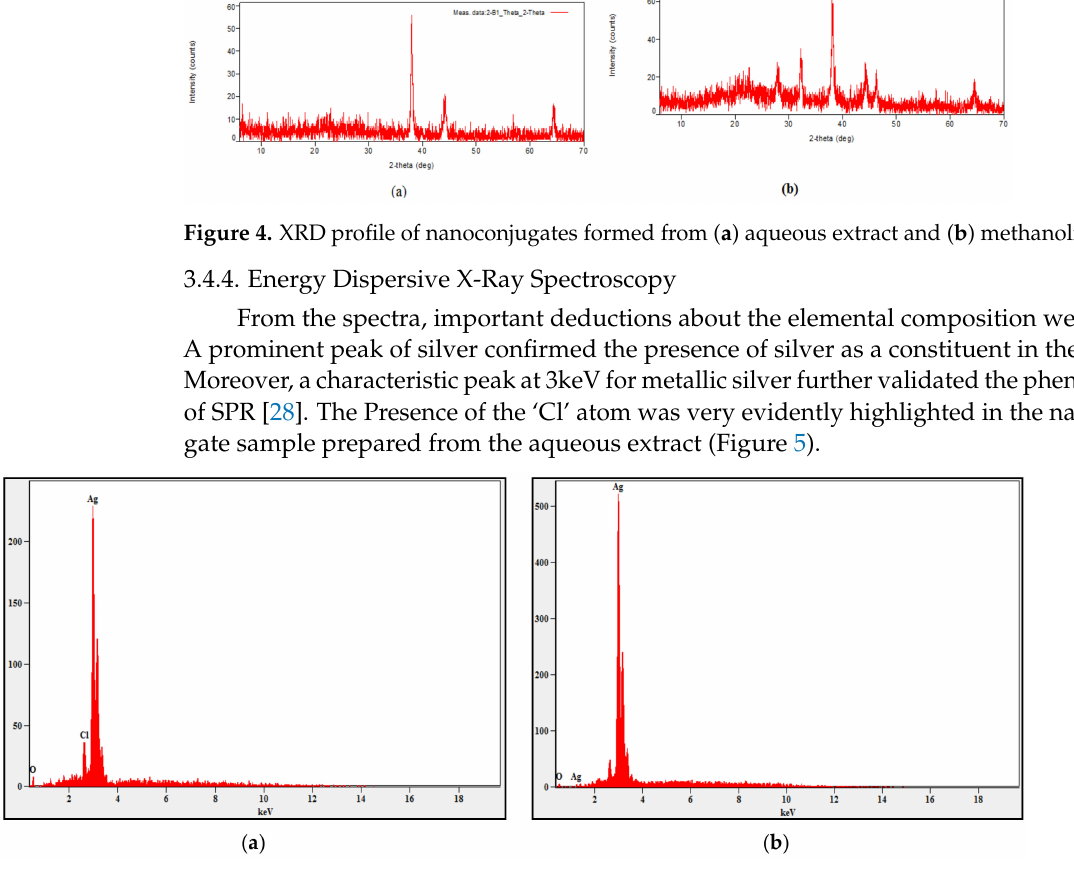
Figure 5. EDAX Spectrum of nanoconjugates formed from ( a ) aqueous extract and ( b ) methanolic